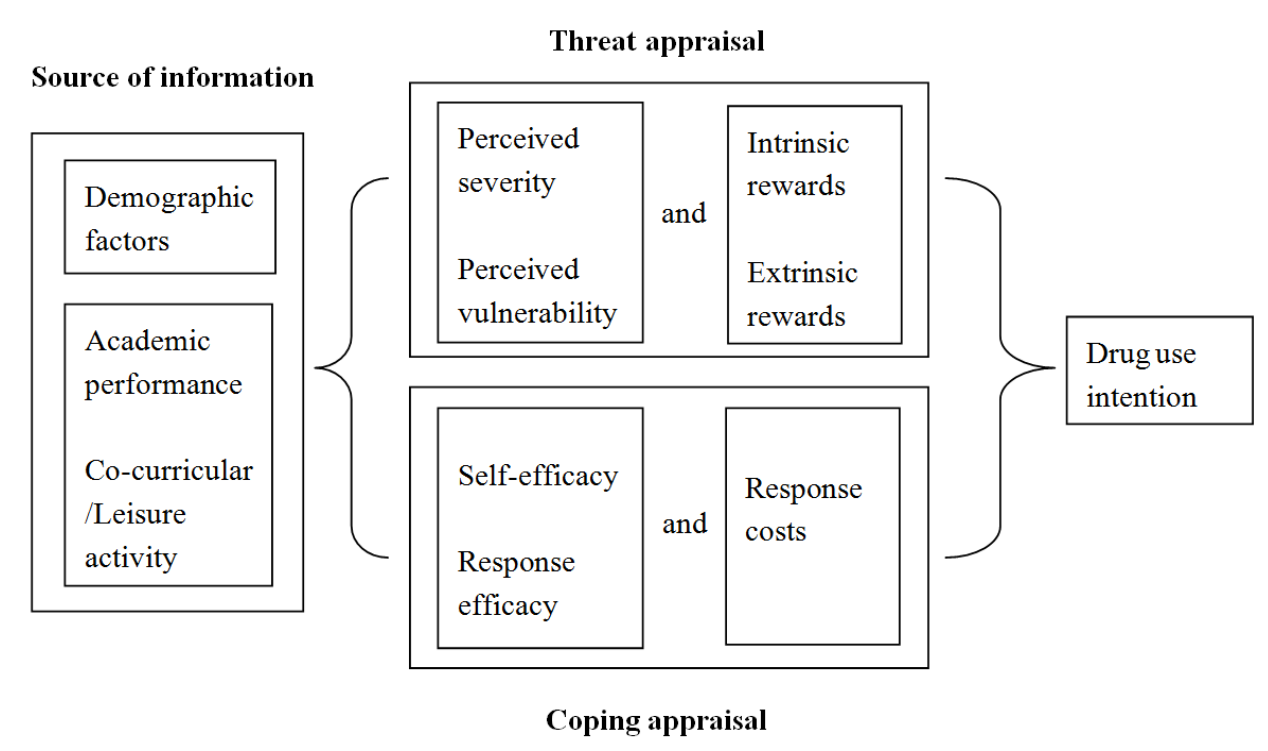
Figure 1. Protective Motivation